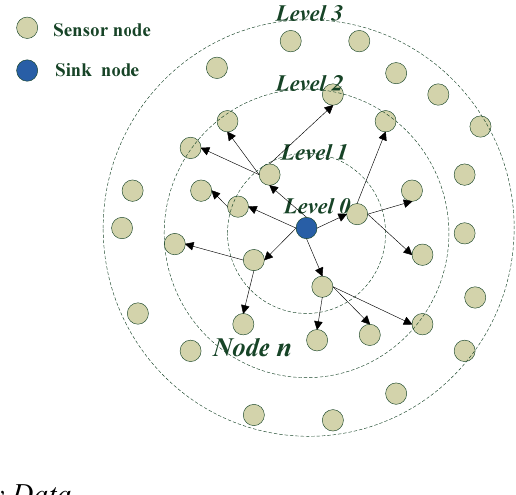
Figure 14. Query packet is broadcasted to Node n .